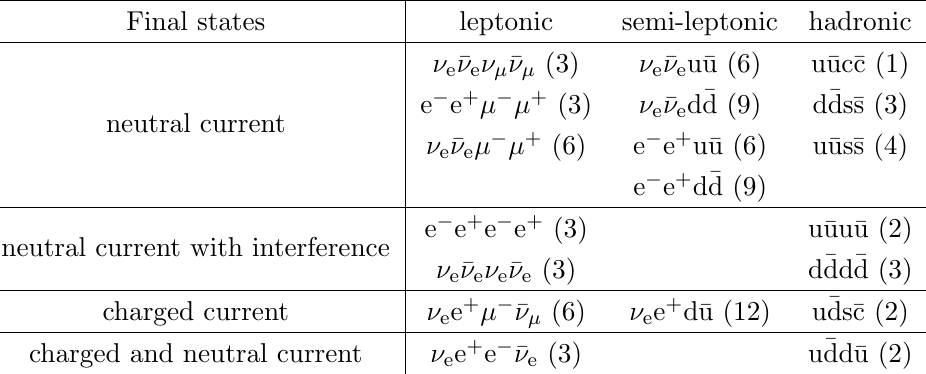
WW = ZZ 4 f . They can be distinguished ! !